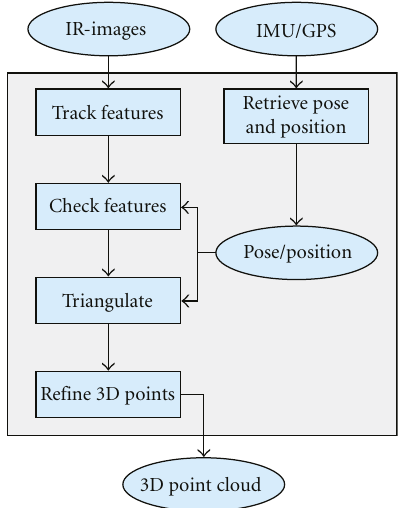
Figure 3: Overview of the SfM modules. Features are tracked in consecutive images and checked for satisfaction of the epipolar constraint. Linear Triangulation of each track of the checked features gives the 3D information. In both steps—constraint checking and triangulation—the retrieved orientation and position information is used. Finally each 3D point are evaluated and